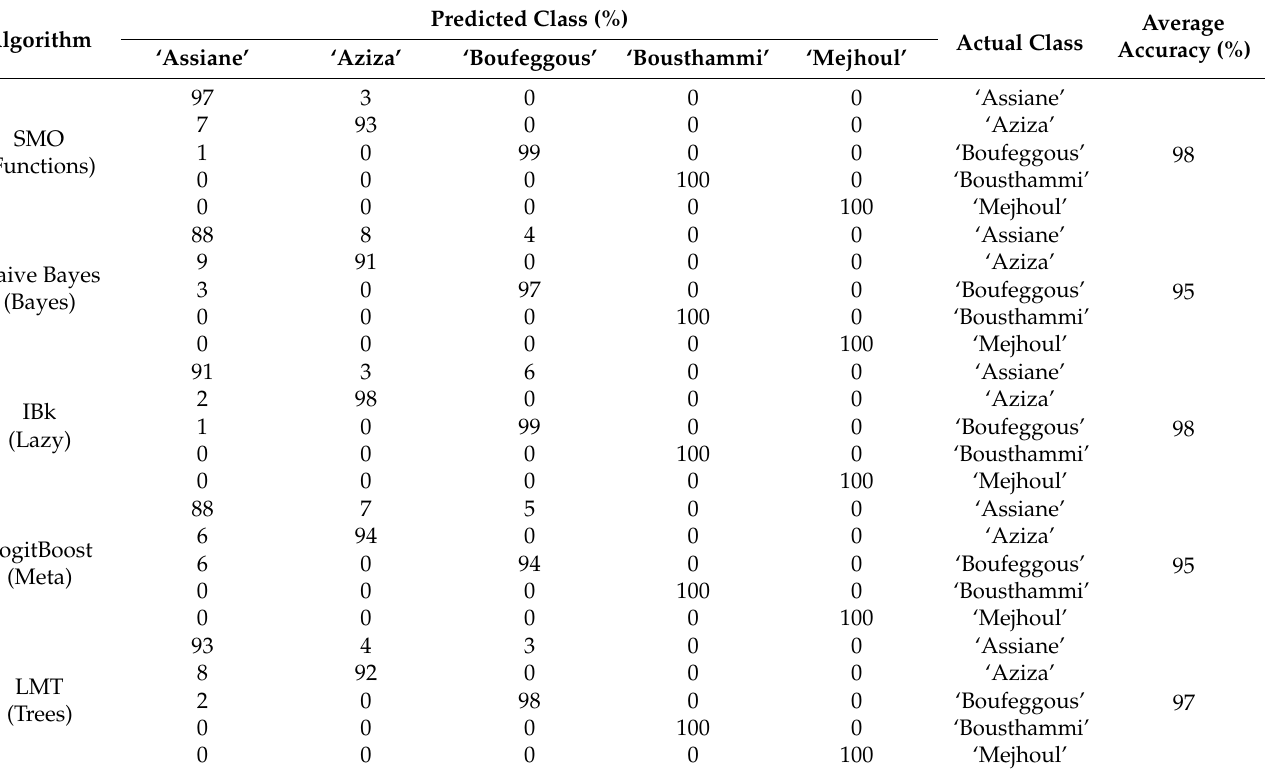
Table 1. Confusion matrices and average accuracies of varietal discrimination of date palm fruits for the models built based on a set of image textures selected from color channels L , a , b , R , G , B , U , V , S , X , Y , and Z